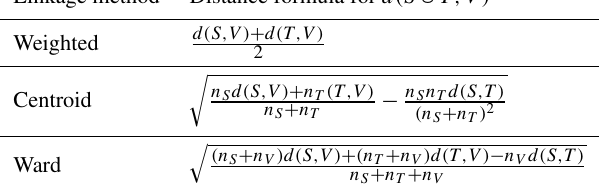
Table 2. Distance formulas for the weighted, centroid, and Ward linkage rules. Here, S and T are two clusters joined into a new clus- ter, whereas V is any another cluster. n S , n T , and n V are the number of objects contained in the clusters S , T , and V .